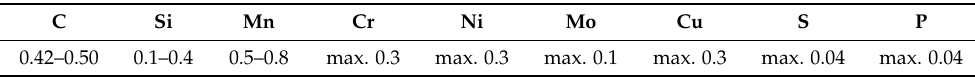
Table 2. Chemical composition of C45 steel (wt.%)